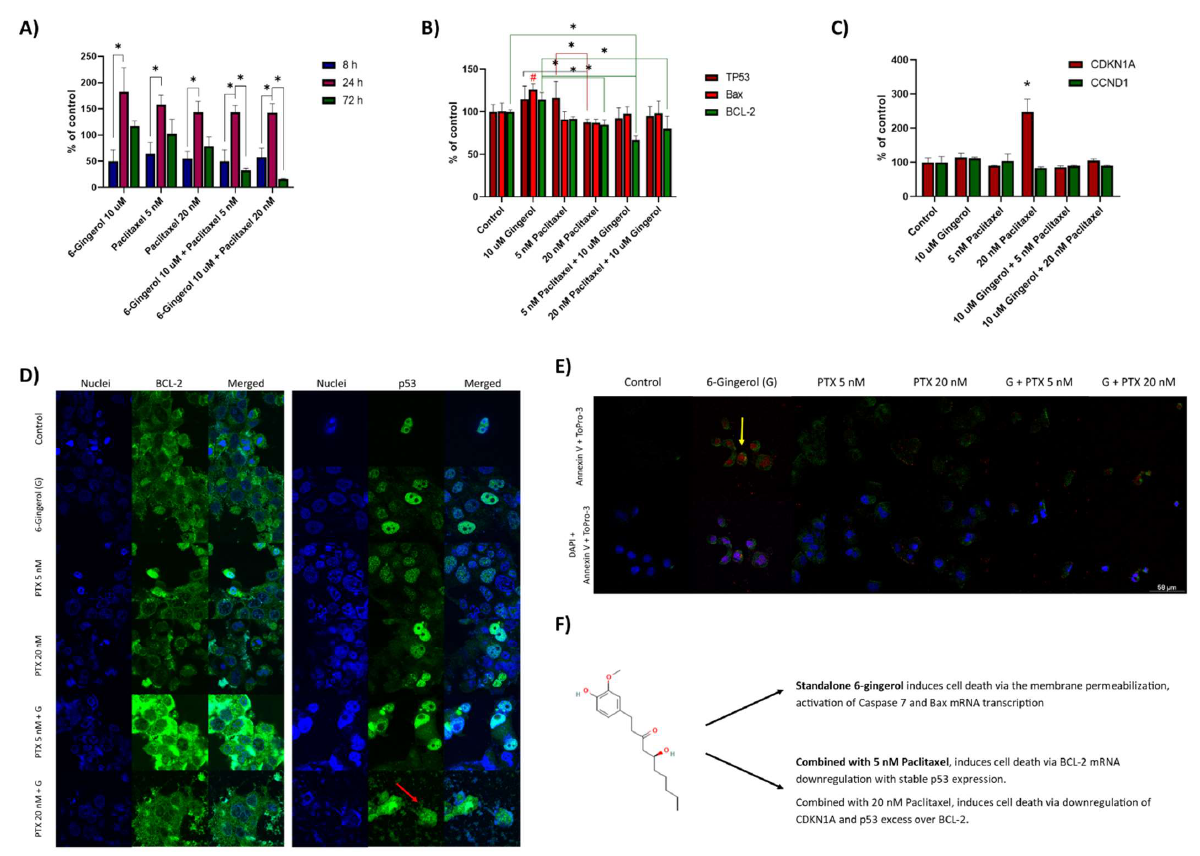
Figure 2. ( A ) Caspase-7 activity in MCF7-WT cells after the combination of 6-Gingerol with Paclitaxel. Data were captured after 8, 24 and 72 h following the start of incubation with the com- pounds. * p < 0.05 ANOVA; ( B ) RT-PCR analysis of TP53, Bax and BCL-2 mRNA in MCF-7/WT cells after 24 h incubation with 6-Gingerol and Paclitaxel. # p < 0.05; * p < 0.05 one-side ANOVA; ( C )